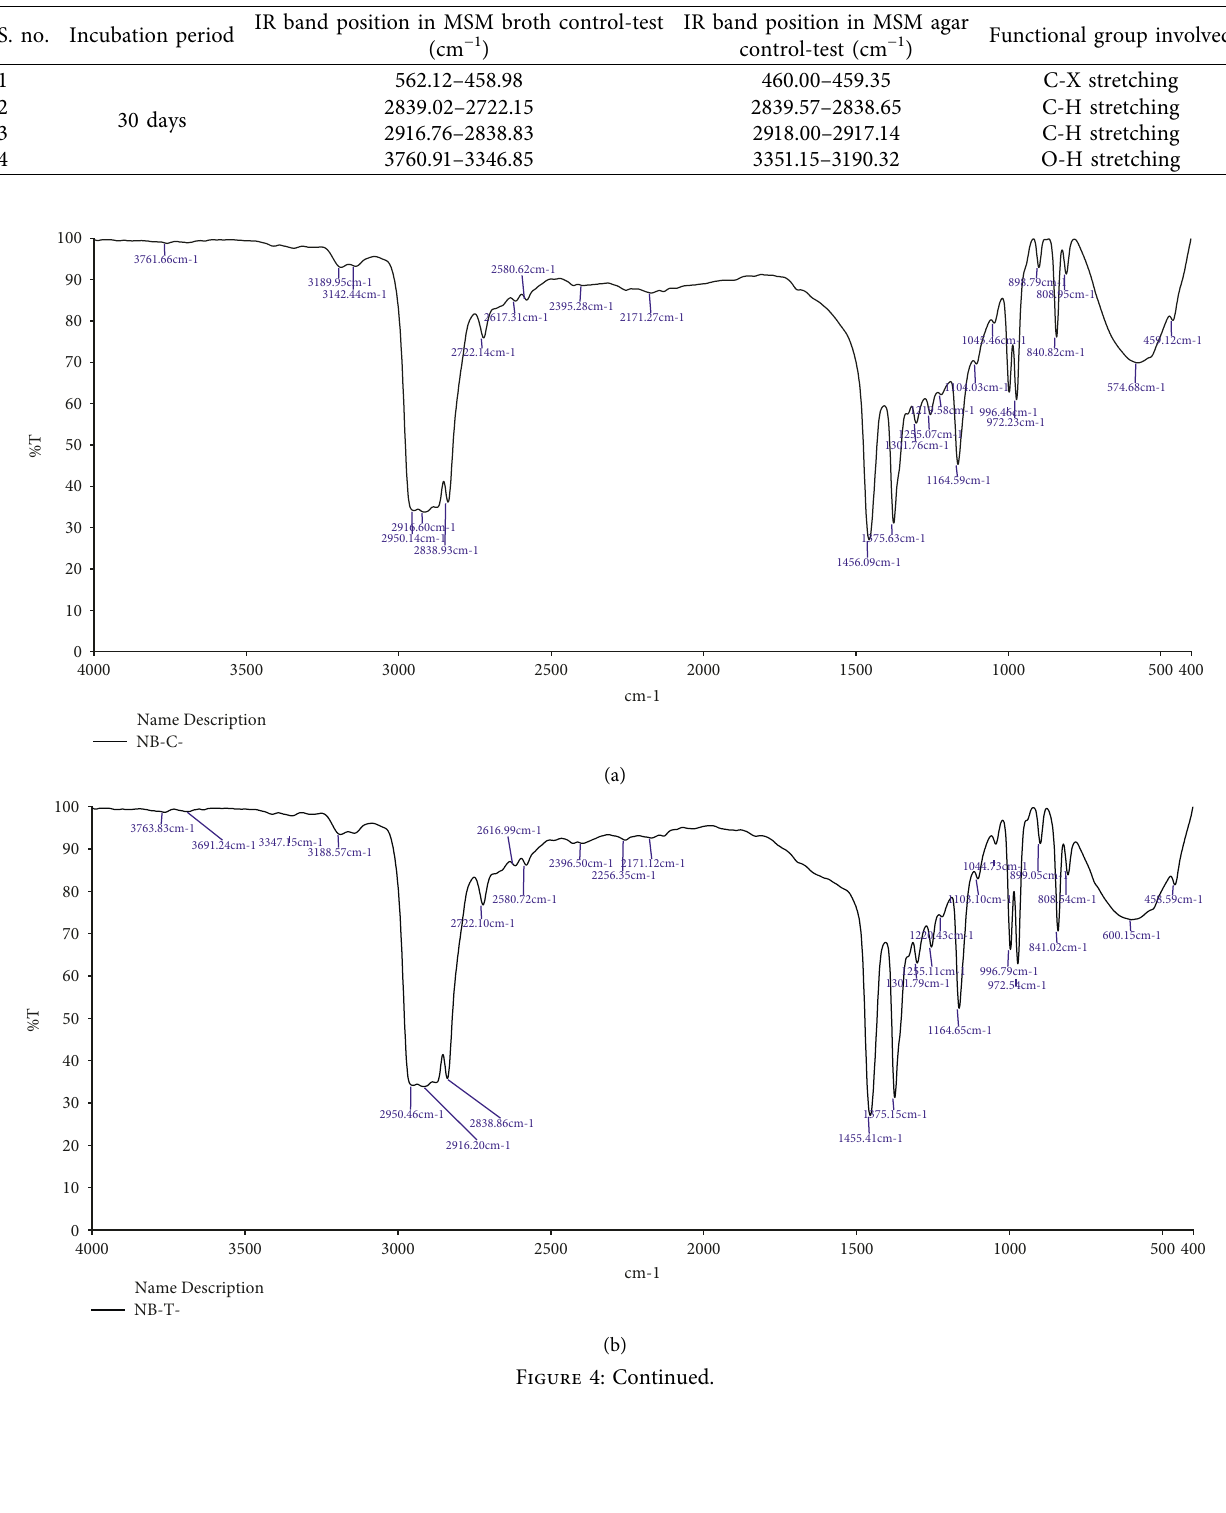
Table 6: Comparison of IR band position in the PP films after incubation with Pseudomonas sp. in MSM broth and MSM agar (both control and